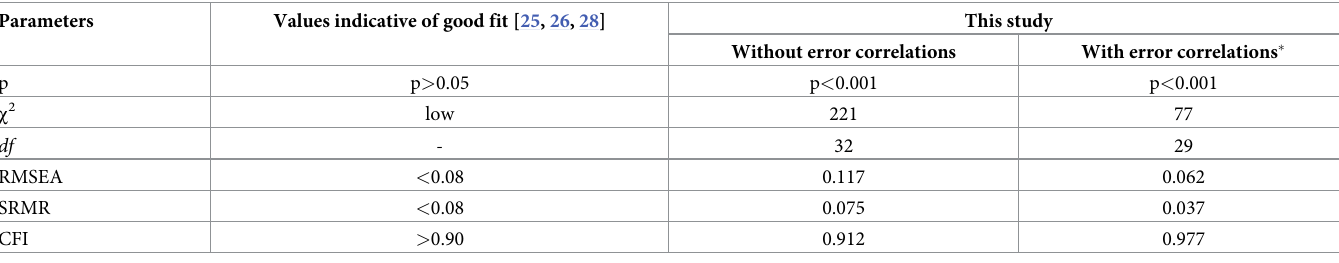
Table 5. Fit parameters for